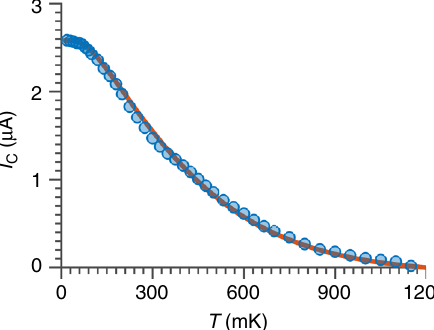
Fig. 7 Temperature dependence of the Josephson current for a high transparency junction. Critical current as a function of the temperature, measured at the fi rst cool down for the junction of Fig. 1c (full circles). The red line is the fi tting considering a quasi-ballistic transport model (see Supplementary Note 6 and Supplementary Equations (5 – 10)). We extract the following fi tting parameters for the mean free path l e = 130 nm and the transparencies of the two barriers D 1 = D 2 = 0.98. From Supplementary Equation (13) the expected normal-state resistance is R N = 70 Ω . The experimental value for R N is instead 35 Ω . The discrepancy between these two values can be attributed to the shunting effect of the bulk of the Bi 2 Te 3 fl